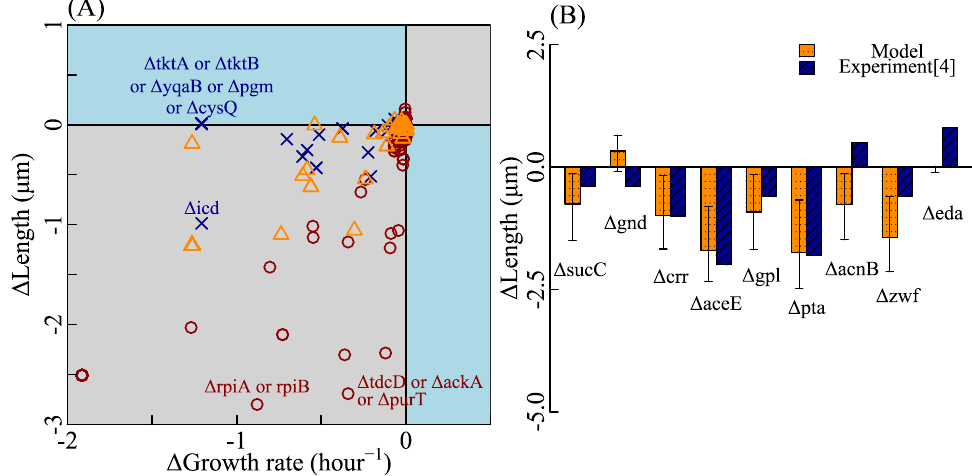
Figure 4. Effects of metabolic gene deletions on growth rate and cell size. ( A ) Each point stands for an Escherichia coli mutant with the same parameters in SEFBA. β is equal to 0.22, which is adapted to metabolic networks iJO1366. Other parameters except for β are the same as Figure 2A. Three colors of points stand for three culture media (written in Table S2). One culture medium corresponds to MOPS medium [6,78] with glucose. One corresponds to M9 medium [25,73,74] with glucose. Another corresponds to rich medium [6] with kinds of amino acids and glucose. The maximum exchange reaction rate of oxygen is 15 mmol/gDW · h, and the maximum exchange reaction rate of glucose is 15 mmol/gDW · h. Detail information of bounds was written in Table S2. Each mutant can have more than one gene deletion and each gene deletion can also switch off more than one reaction in metabolic reactions network. The detailed information about mutants was written in Table S3. ( B ) Comparison between experimental data [4] and SEFBA results of nine mutants of metabolic gene deletions. Twenty kinds of bounds were used in SEFBA to simulate different culture media (Table S1). For each kind of bound, we varied the glucose exchange rate to have the predicted growth rate of FBA close to the experimental data. The ordinate is the variation in cell length of Escherichia coli strains with gene deletions compared to that without gene deletions. The error bars are the minimum and maximum values of cell length variation among 20 kinds of culture